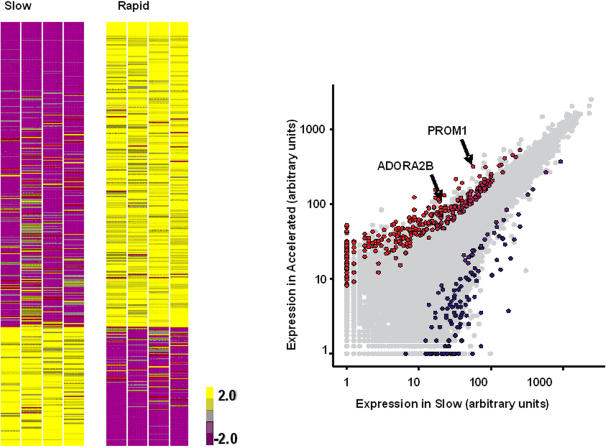
Gene expression patterns that distinguish “rapid” progressors from “slow” progressors.(A) Infogram of 437 differentially expressed genes in individual rapid and slow progressor patients. The expression levels for each gene were normalized to the geometric mean of all the samples for each gene. Increased genes are shown in progressively brighter shades of yellow, and decreased genes are shown in progressively darker shades of blue. Genes shown in gray are not different between the groups. The genes were ranked according to their significance level. (B) A log scale scatter plot of the average of intensity of all the genes on the arrays in rapid progressors (X-axis) and slow progressors (Y-axis). Colored points-437 genes that were significantly changed (p-value <0.05 in TNoM and t-test and fold ratio >2). Points are colored by their fold ratios; progressive shades of blue indicate increase and progressive shades of red indicate decrease. Points colored in gray did not reach significance. Adenosine A2B receptor (ADORA2B) and prominin-1/CD133 (PROM1) were among the most upregulated genes in the “rapid” progressor group.